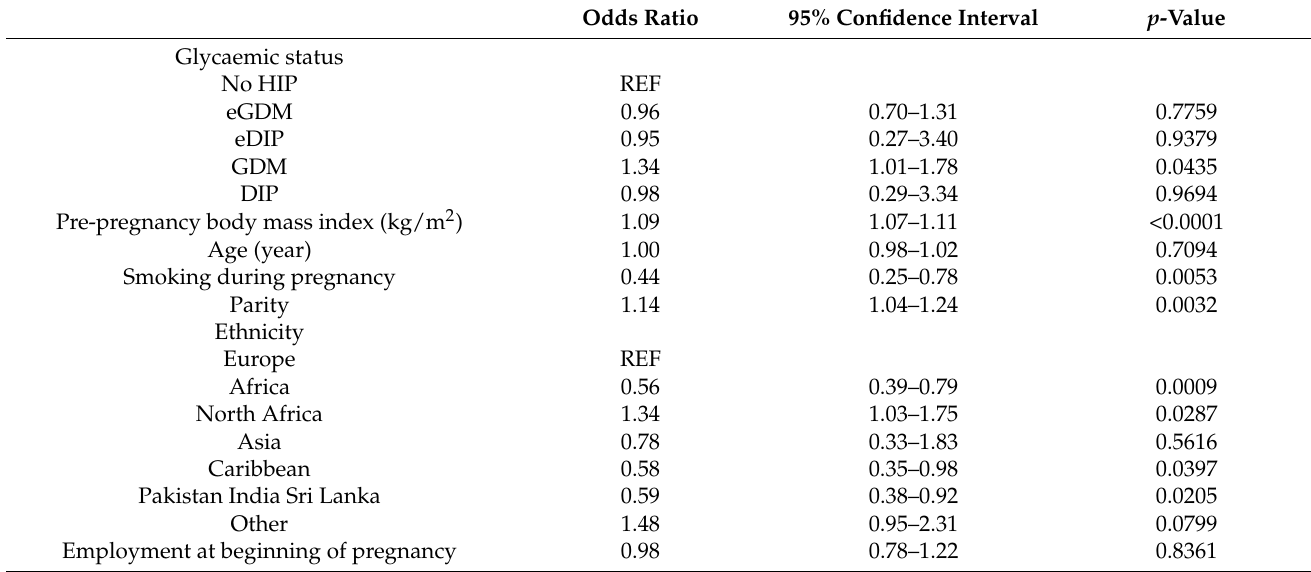
Table 3. Determinants of large-for-gestational infant in multivariable